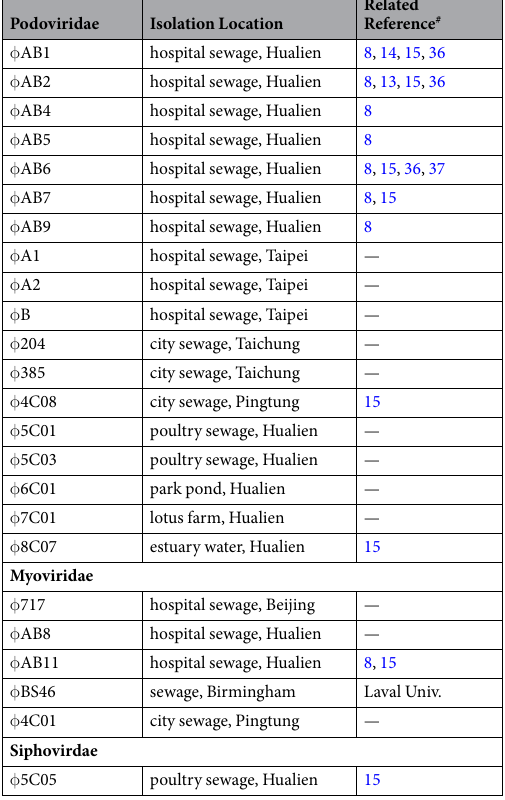
Table 3. The 24 specific phages used in this study to evaluate the fitness costs associated with resistance to isolated phages and antibiotics. # Relevant reference for each specific